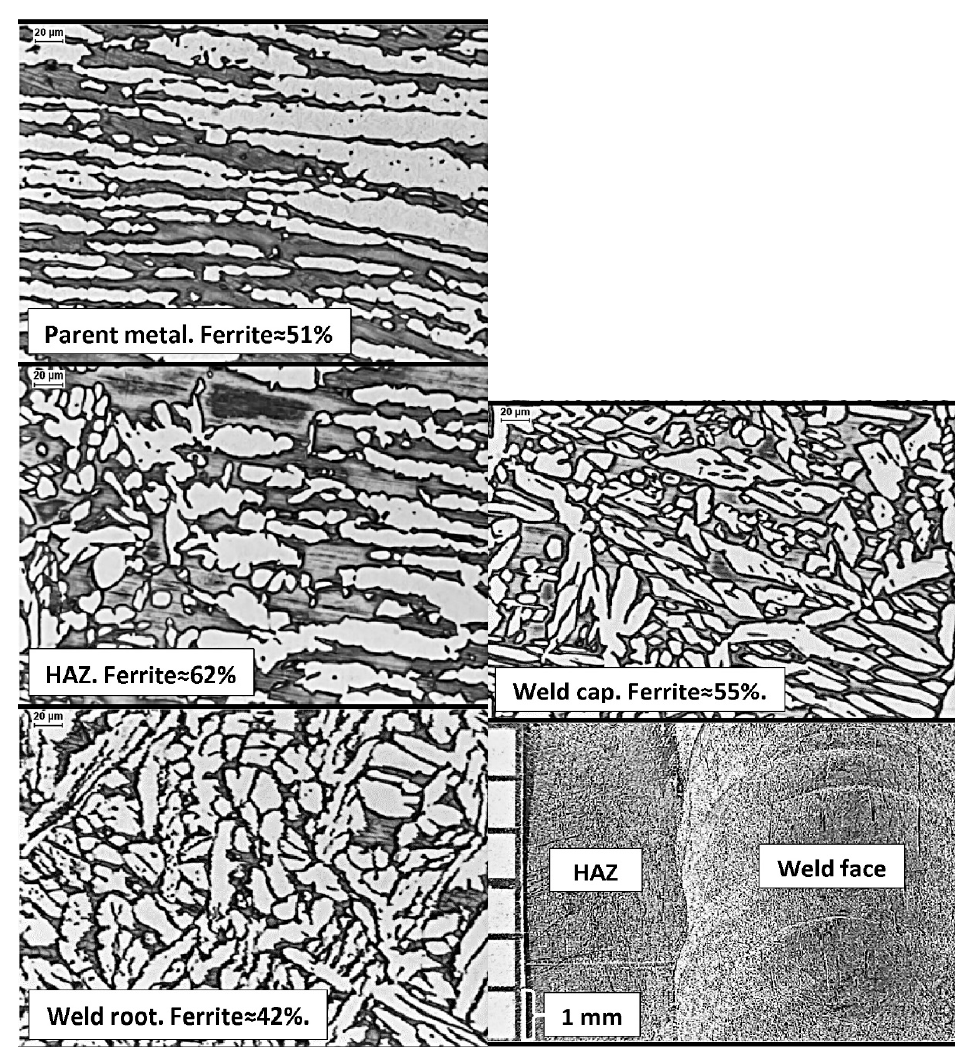
Figure 15. Authors’ analysis of welded connection made of duplex DSS steel with high resistance to pitting corrosion identified for the environment of chlorides.